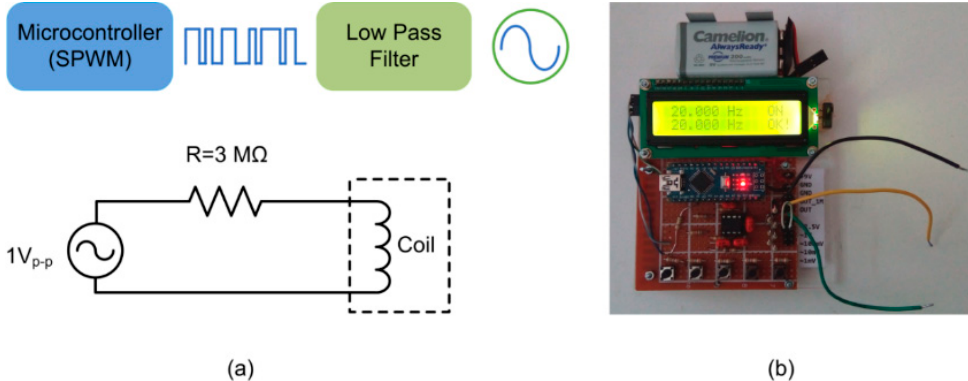
Figure 4. ( a ) Signal generator block diagram; ( b ) constructed 9 V power signal generator.